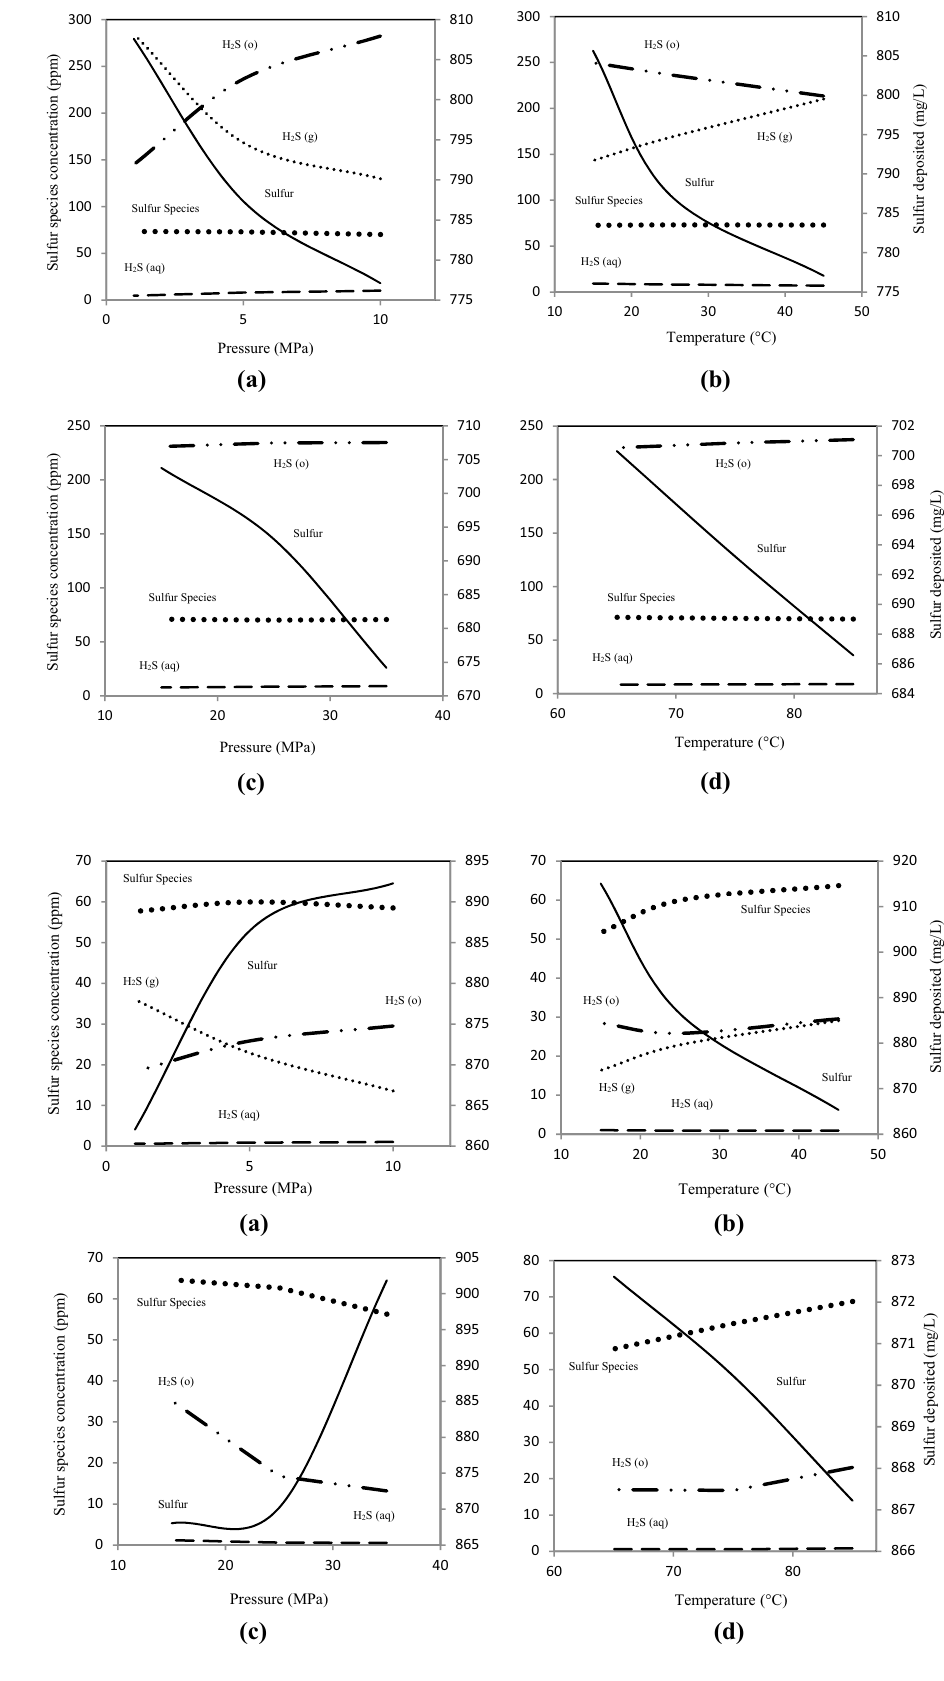
Fig. 2 The effects of tem- perature and pressure on sulfur speciation, solid-phase formation, and H 2 S partitioning, aqueous-phase reactions, initial pH: 7, a T : 25 °C, b P : 1 MPa,